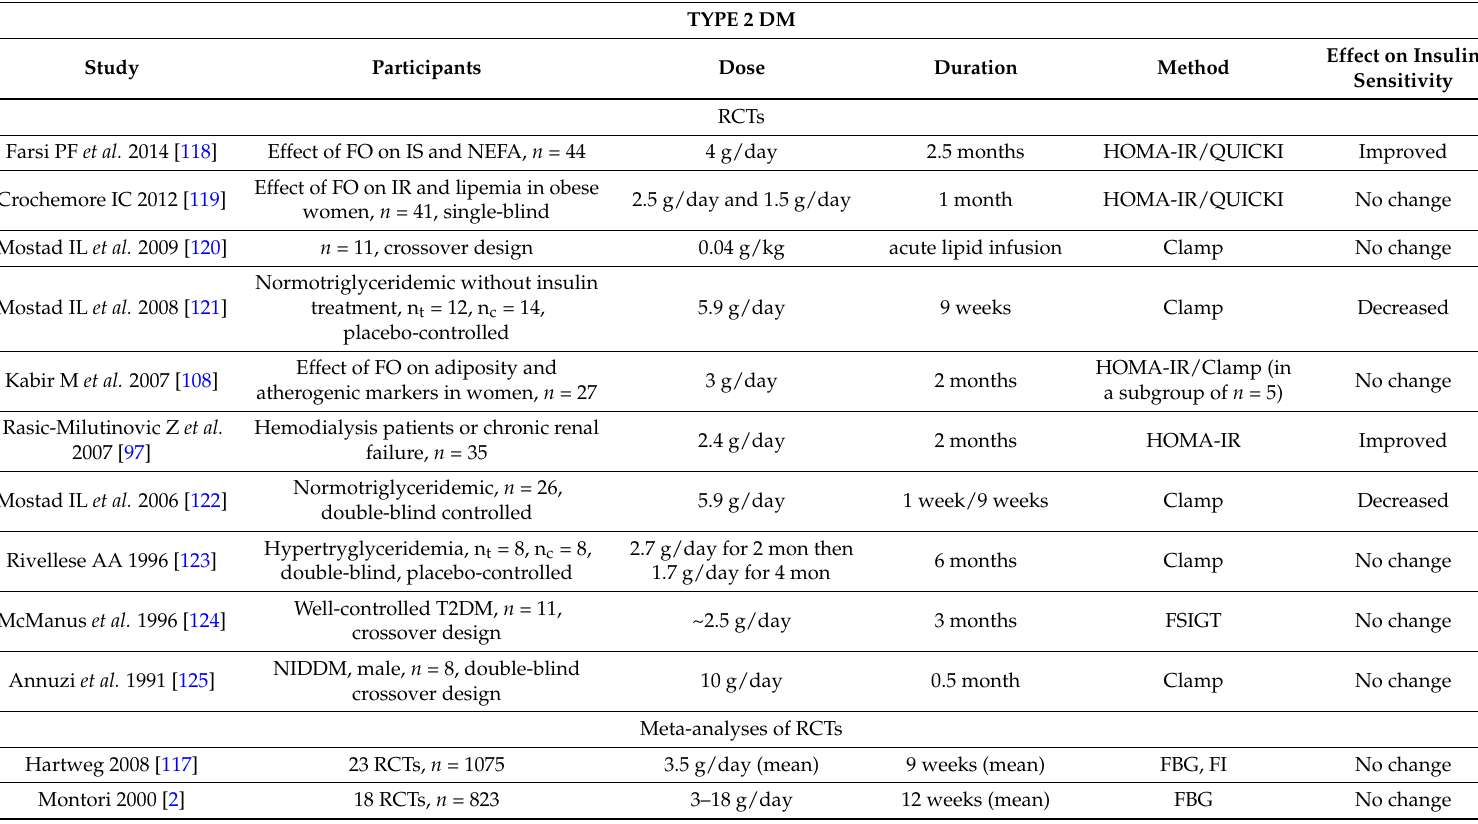
Table 3. Summary of human studies of the n -3 PUFA effect on Type 2 DM